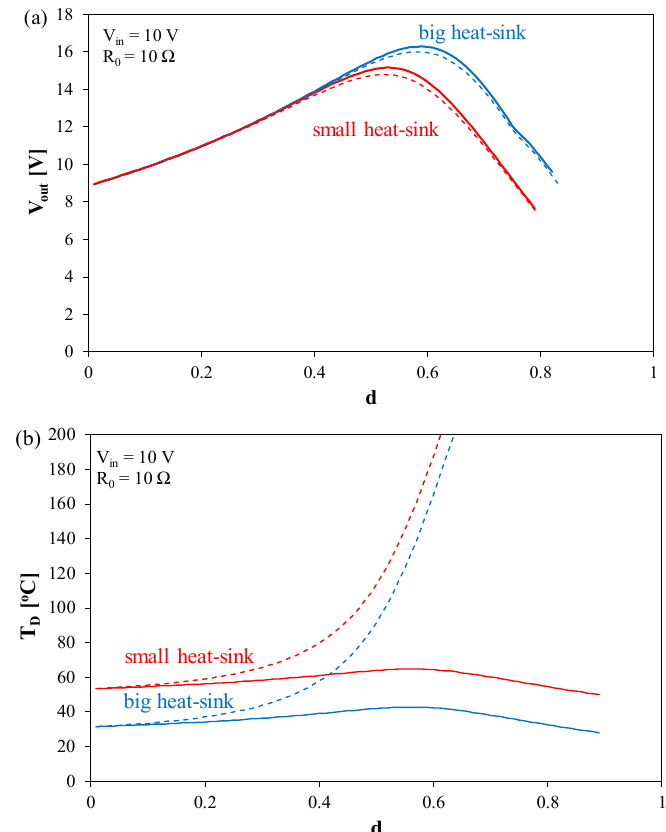
Figure 13. Computed dependences of: ( a ) the boost converter output voltage, ( b ) the diode internal temperature on the duty cycle taking into account mutual thermal interactions between the diode and the transistor.